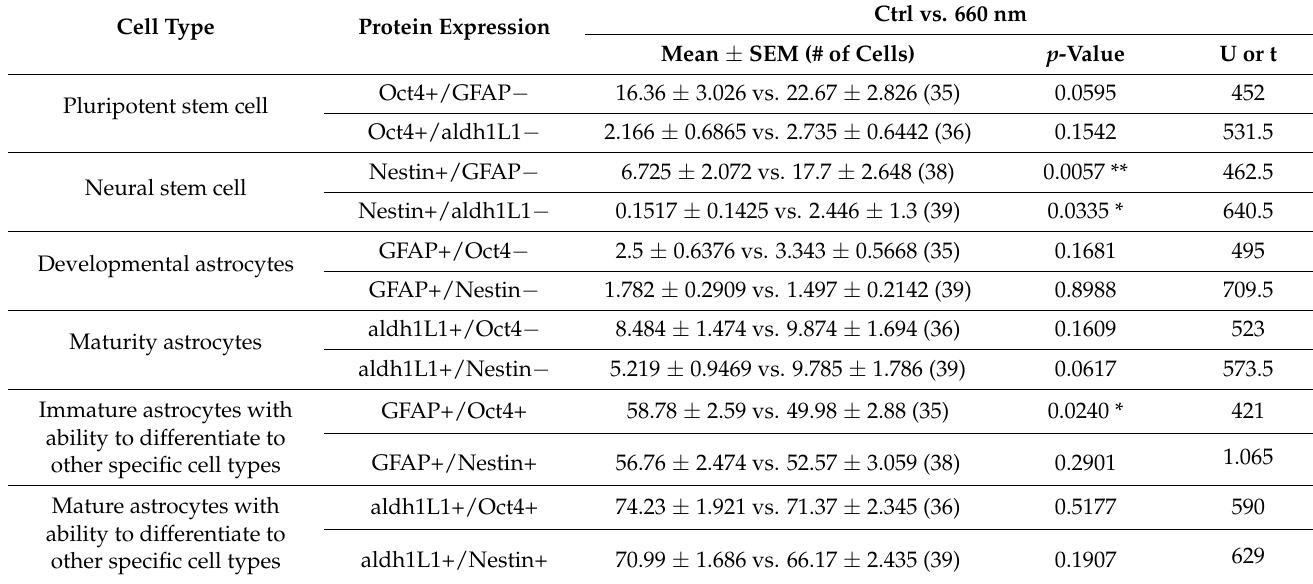
Table 2. Demonstration of Presented Cell Types Depends on Protein Expression. Glial fibrillary acidic protein: GFAP; aldehyde dehydrogenase 1 family member L1: aldh1L1; octamer-binding transcription factor 4: Oct4U: Mann–Whitney U-test; t: Unpaired t -test; (* p < 0.05; ** p <